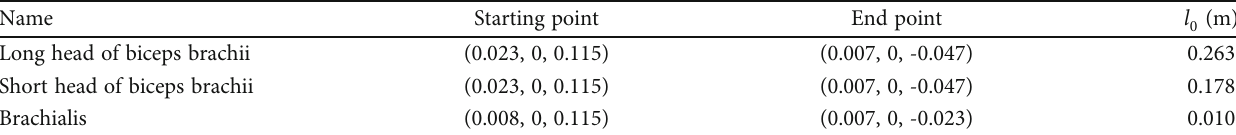
Table 3: Spatial position of starting and ending points of fl exion muscles.